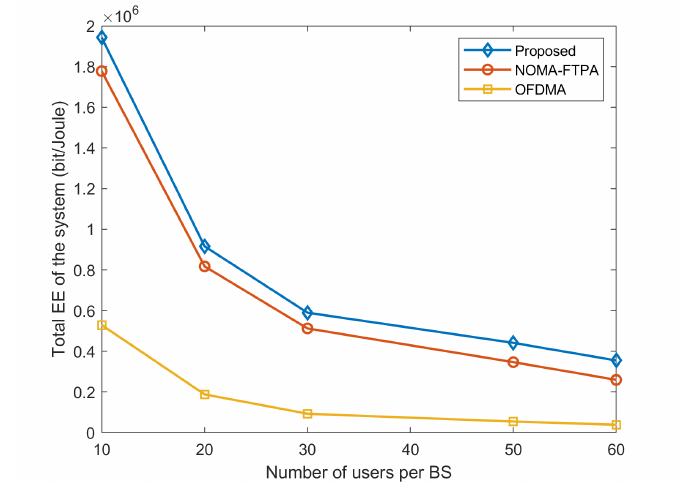
Figure 5. Total energy efficiency versus different number of users per BS.